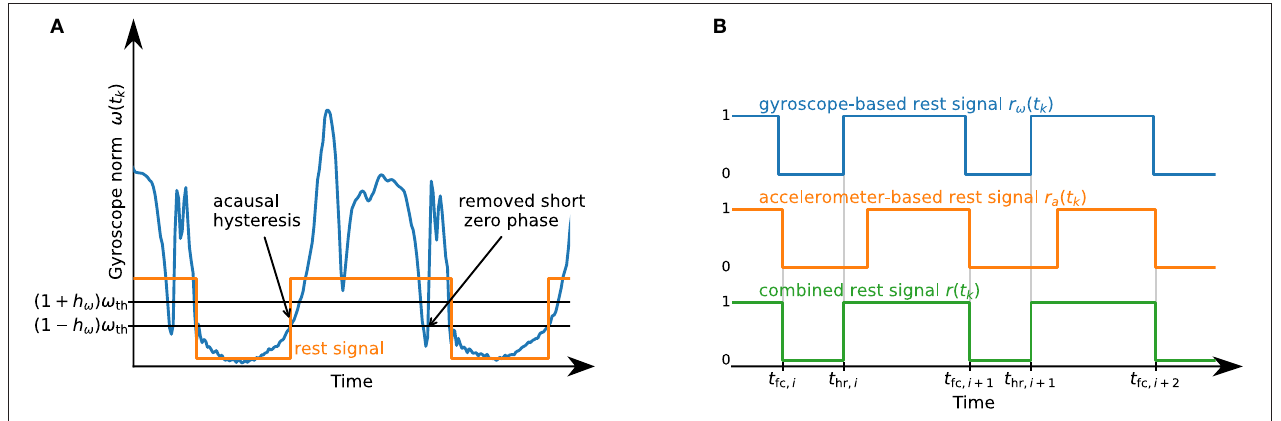
FIGURE 5 | (A) Illustration of the thresholding algorithm. Acausal hysteresis and the removal of short phases ensure the robust detection of the desired rest phase. (B) Illustration of the combination of r ω ( t k ) and r a ( t k ) into r ( t k ). By using the OR combination of the accelerometer- and gyroscope-based signals, we are able to robustly detect when the foot is not fully on the ground.